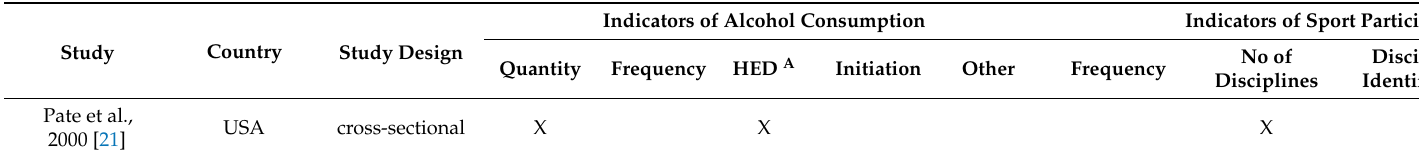
Table 2. The location, methodology, and main outcomes from reviewed